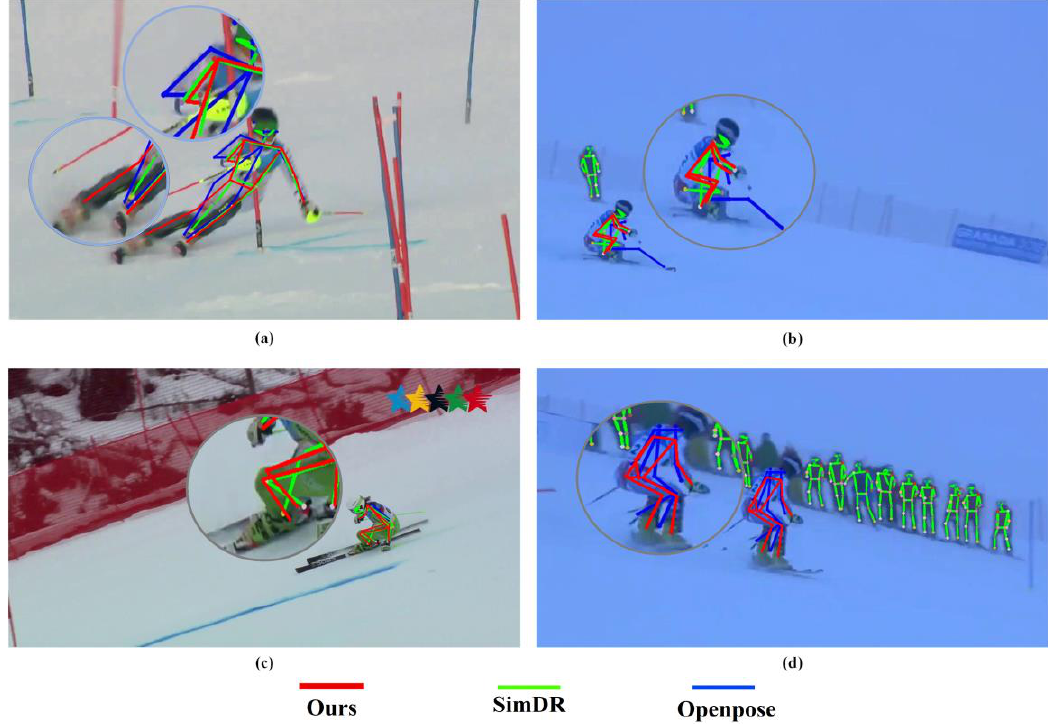
Figure 7. The results of different algorithms in the same video sequence. In ( a ), the algorithm in this article has more accurate results for the right foot and elbow. In ( b ), the position of the method in this paper is relatively accurate, and the OpenPose estimation shows key-point drift. In ( c ), the OpenPose method was not recognized and the left and right leg points of the SimDR method were